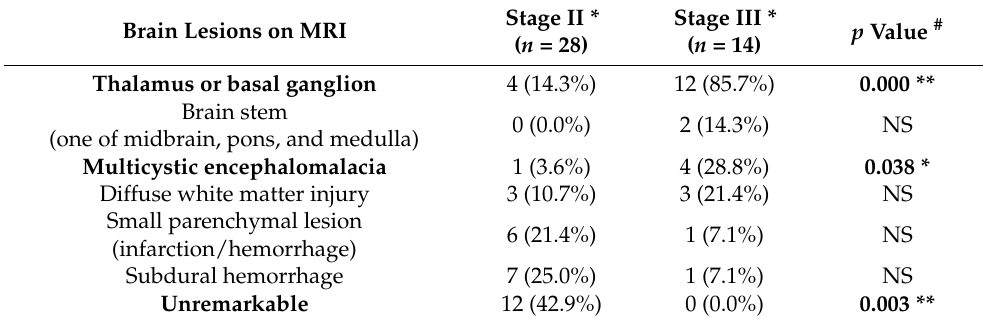
Table 3. Brain MRI results for stage II and stage III patients in group 2 after hypothermia rescue therapy.